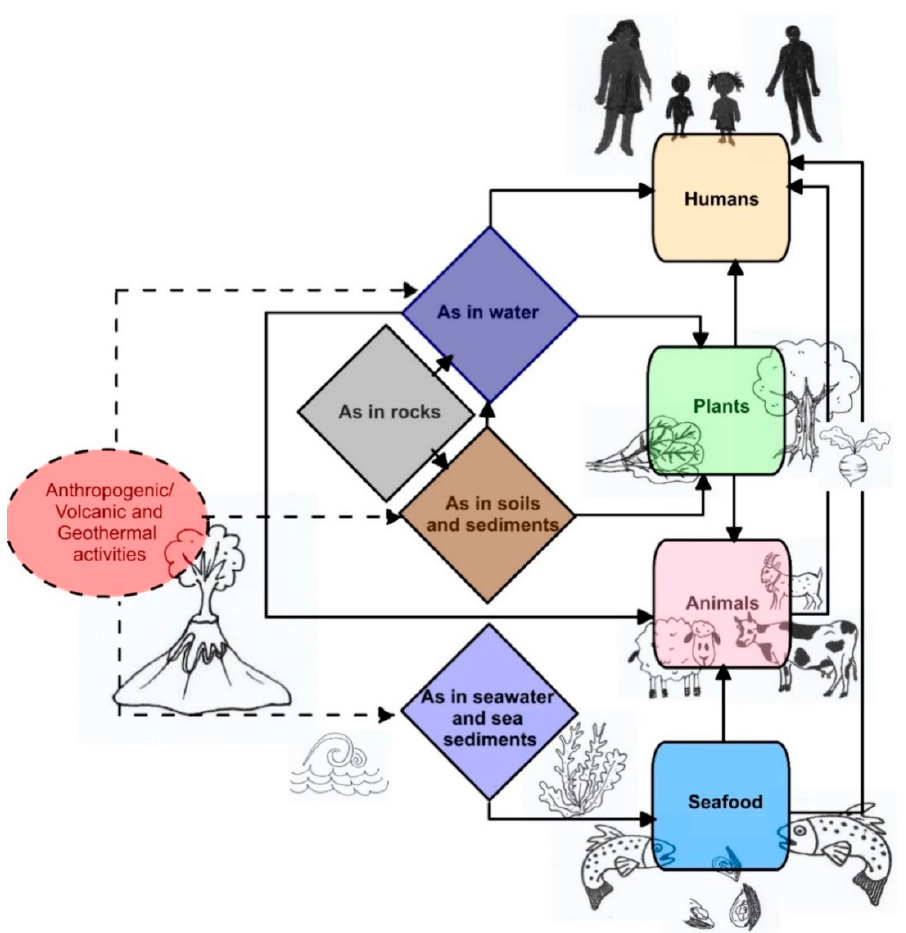
Figure 1. Schematic diagram is showing As cycle in the environment.